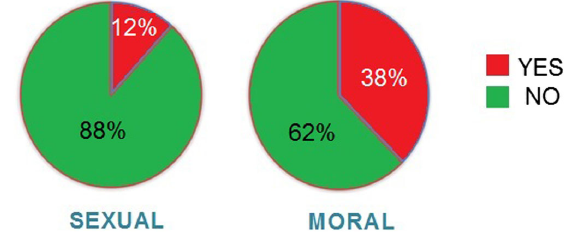
FIG. 6. Percentage of respondents reporting sexual or moral harassment.